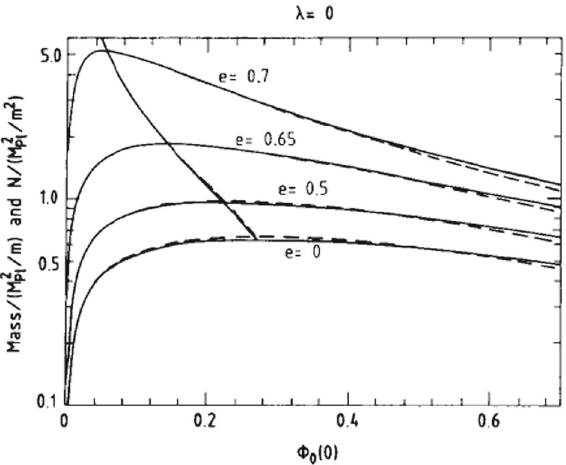
Fig. 5 The mass (solid) and the number of particles (dashed) versus central scalar value for charged boson starswithfourvaluesof ˜ e asdefinedinSect.3.3.Themostly-verticallinescrossingthefourplotsindicatethe solution for each case with the maximum mass (solid) and maximum particle number (dashed). Reprinted with permission from Jetzer and van der Bij (1989); copyright by